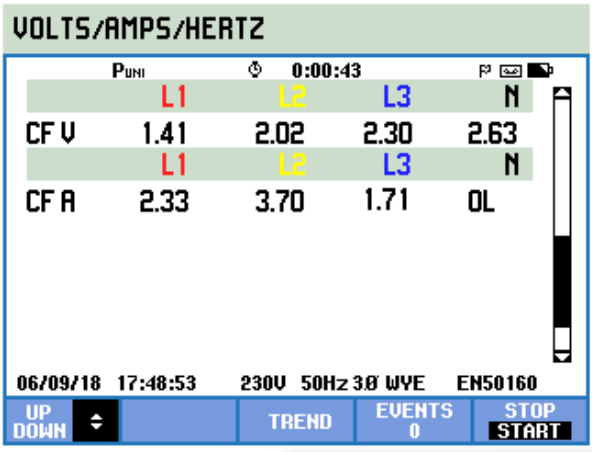
Figure 32. Crest factor at the point of common coupling.